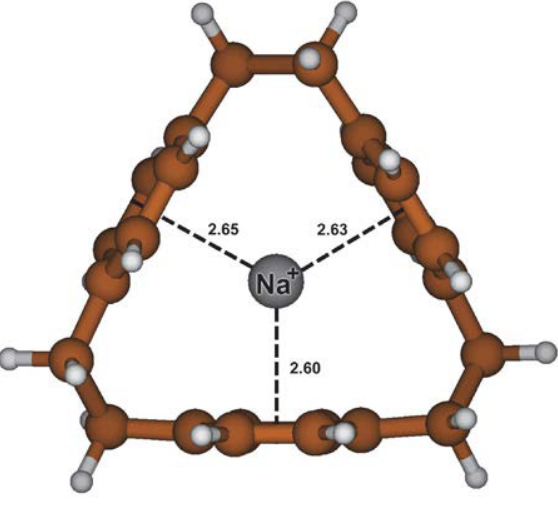
Figure 6. DFT optimized structure of the [Na(C 24 H 24 )] + complex (ω-B97XD / def2-TZVP); the distances between the “central” cation Na + and the centroids of the three benzene rings are 2.65, 2.63, and 2.60 Å (Ref. 24